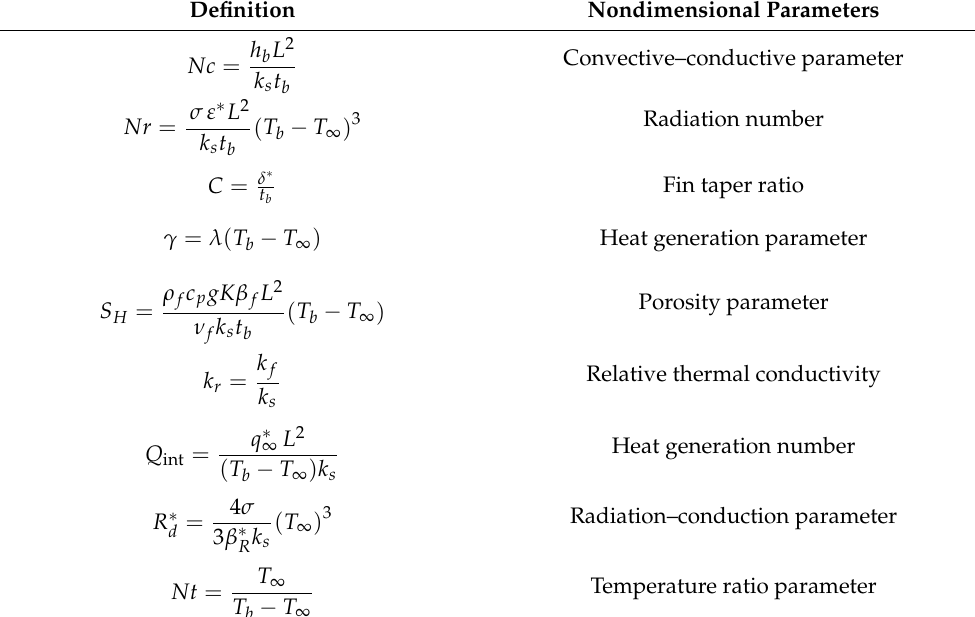
Table 1. Nondimensional parameters present in the dimensionless fin